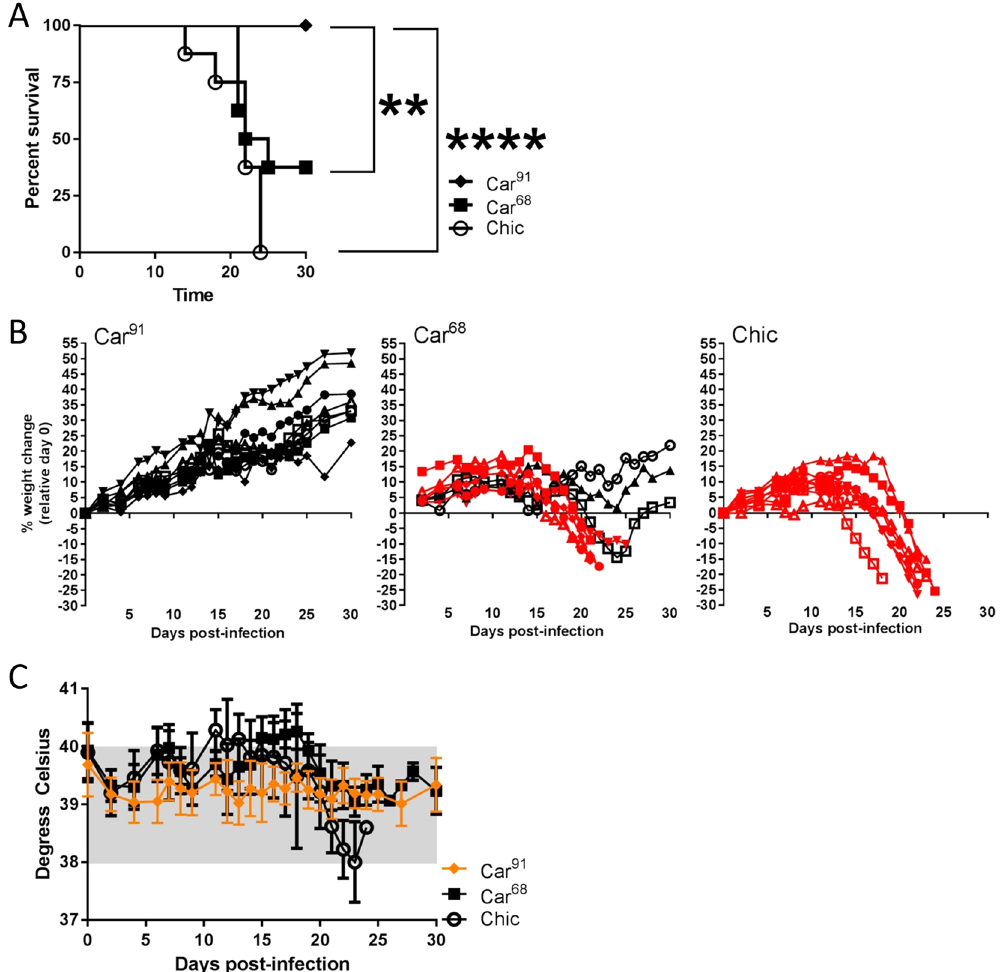
Figure 1. Infection of Hartley guinea pigs with MACV strain Car 68 , Car 91 and Chicava. ( A ) Guinea pigs were challenged with 1,000 pfu of Car 91 , Car 68 and Chic by the i.p. route. Survival was monitored for 30 days post- infection. Asterisks denote statistical significance. ( B ) Percent weight loss for individual guinea pigs in the indicated groups was plotted based on day 0 starting weight. Animals succumbing to infection are shown in red. ( C ) The mean group temperatures were plotted. The normal temperature range is shaded in grey. To aid visualization, data for Car 91 -infected animals is depicted in